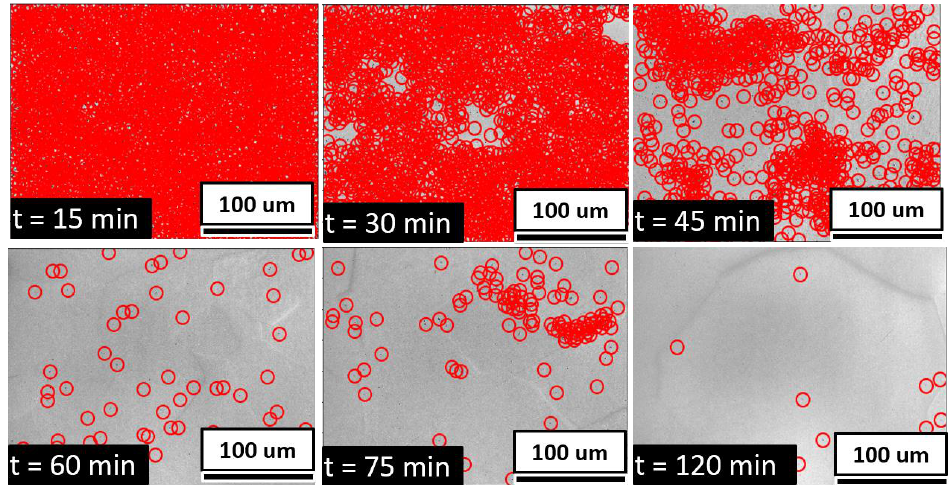
Figure 10. Identified particles from the laser confocal images (Figure 9) with edge-detection algo- rithms (OpenCV). Red circles correspond to locations there are embedded diamonds. Scale is defined in pixels.